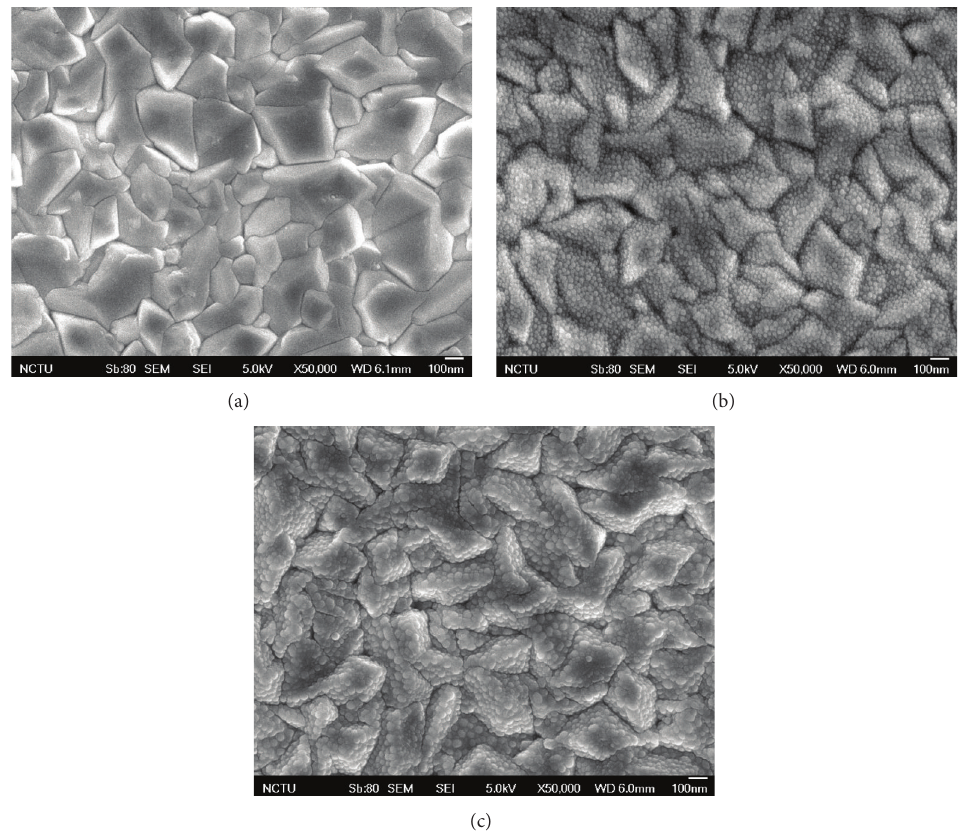
Figure 2: Plane-view SEM images of the textured FTO films (a) without H 2 plasma exposure, or with the H 2 plasma exposure for (b) 72 seconds and (c) 900 seconds.